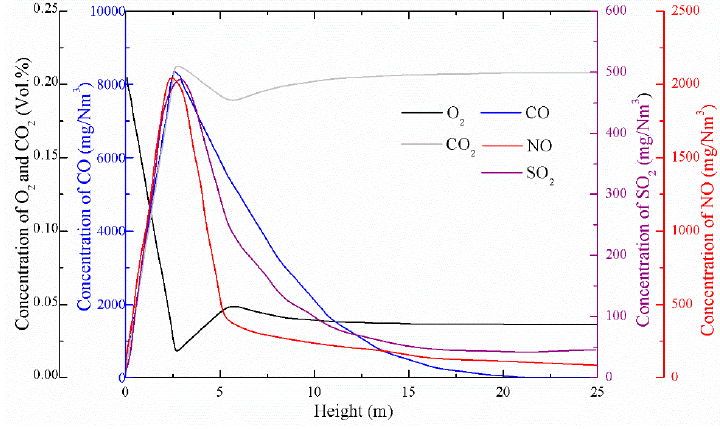
Figure 12. Distribution of gas concentrations along the height from the simulation.